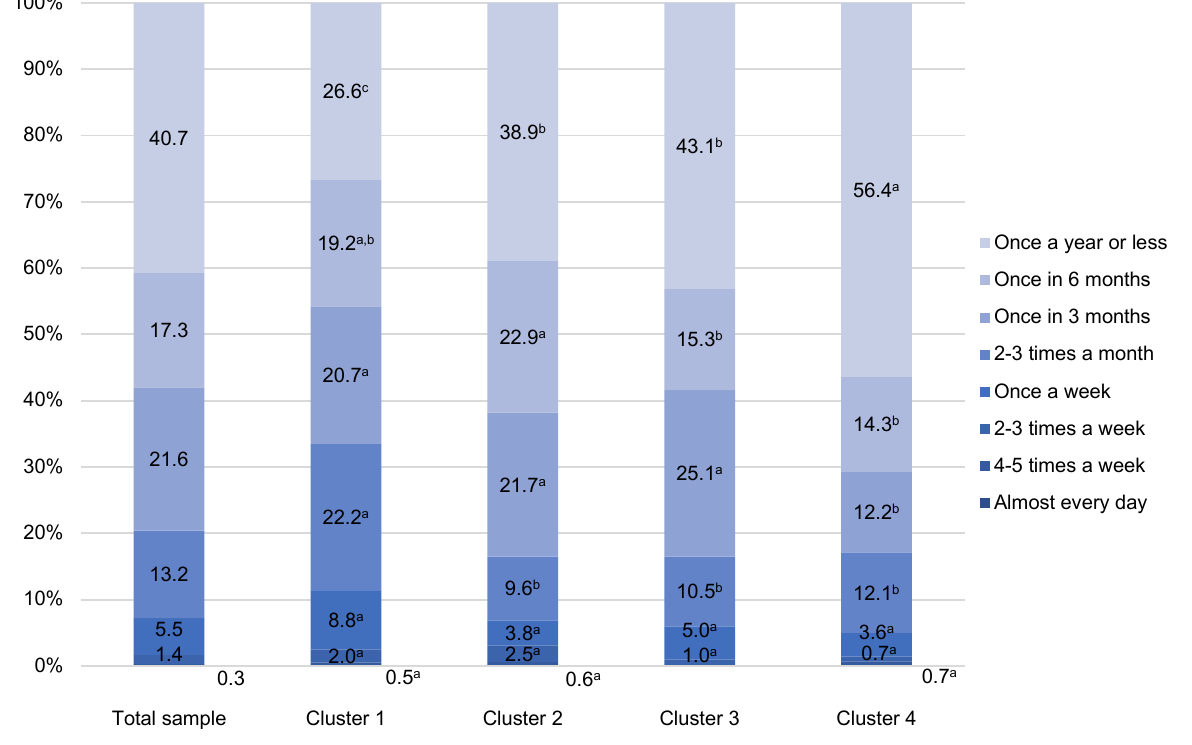
Figure 4. Away-from-home fatty fish consumption of Croatian fishery consumers (n = 918). a–c Dif- ferent letters in the same consumption frequency category indicate statistically significant differences ( p < 0.001).